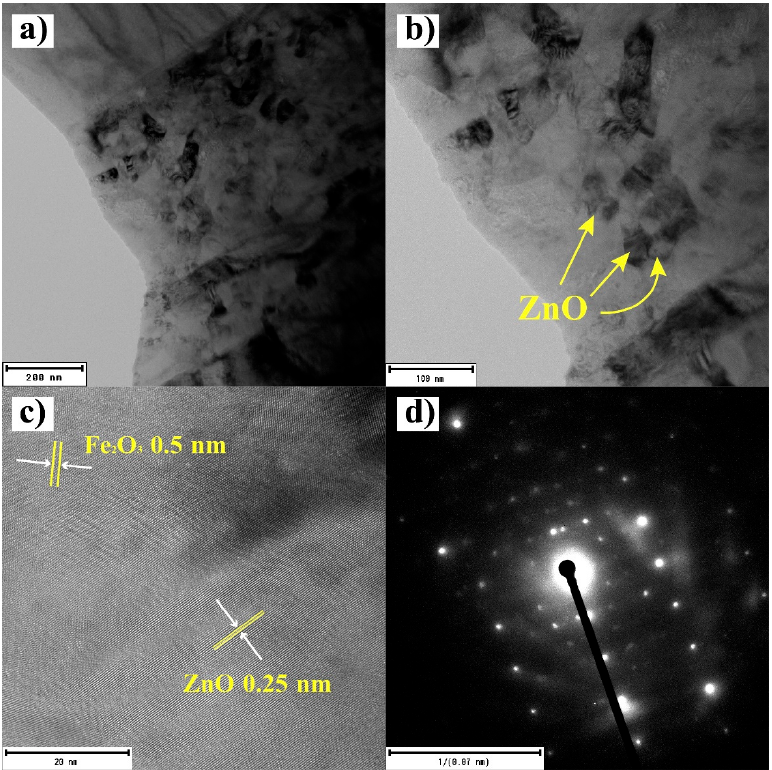
Figure 8. Low ( a , b ) and high ( c ) resolution TEM images and SAED pattern ( d ) for the Fe 2 O 3 :ZnO material.